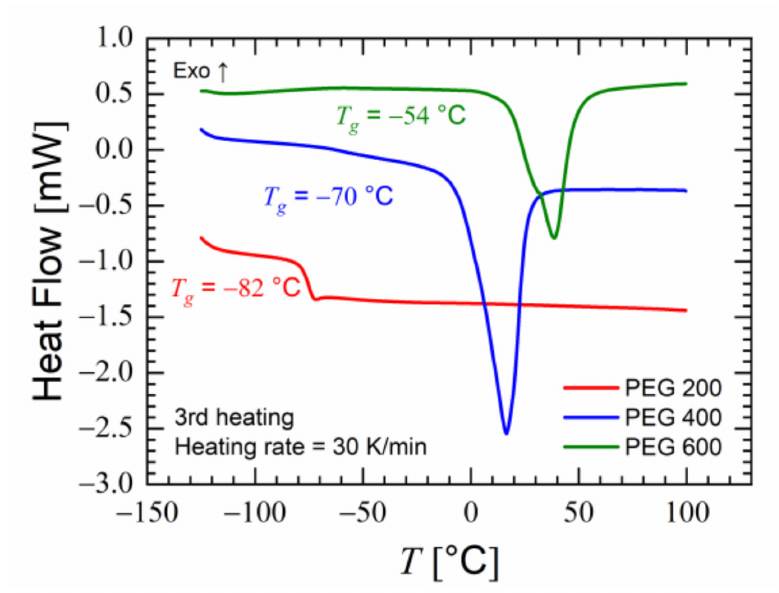
Figure 4. Heat flow measured using differential scanning calorimetry (DSC) during the third heating cycle of PEG 200, 400 and